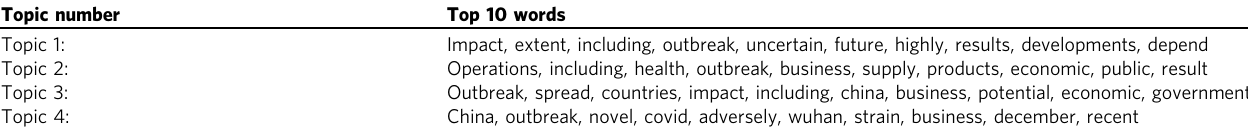
Table 3 Results of an LDA topic modelling with four topics. The algorithmically derived topics give a good insight into the general narratives of risks used in the documents.